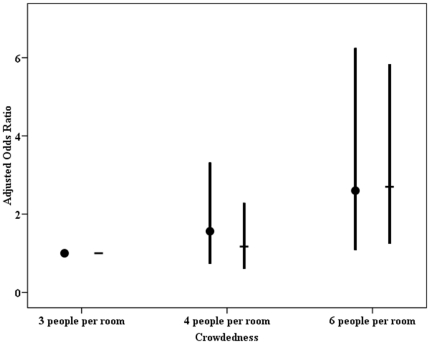
Associations between crowdedness and common cold annual incidence ≥6 times and duration ≥2 weeks.Odds ratios were adjusted for gender, age, hours spent indoors, family member allergy history and exposure to environmental tobacco smoke. Circles represent adjusted odds ratio (AOR) for incidence. Dashes represent AOR for duration. 95% confidence interval is demonstrated.